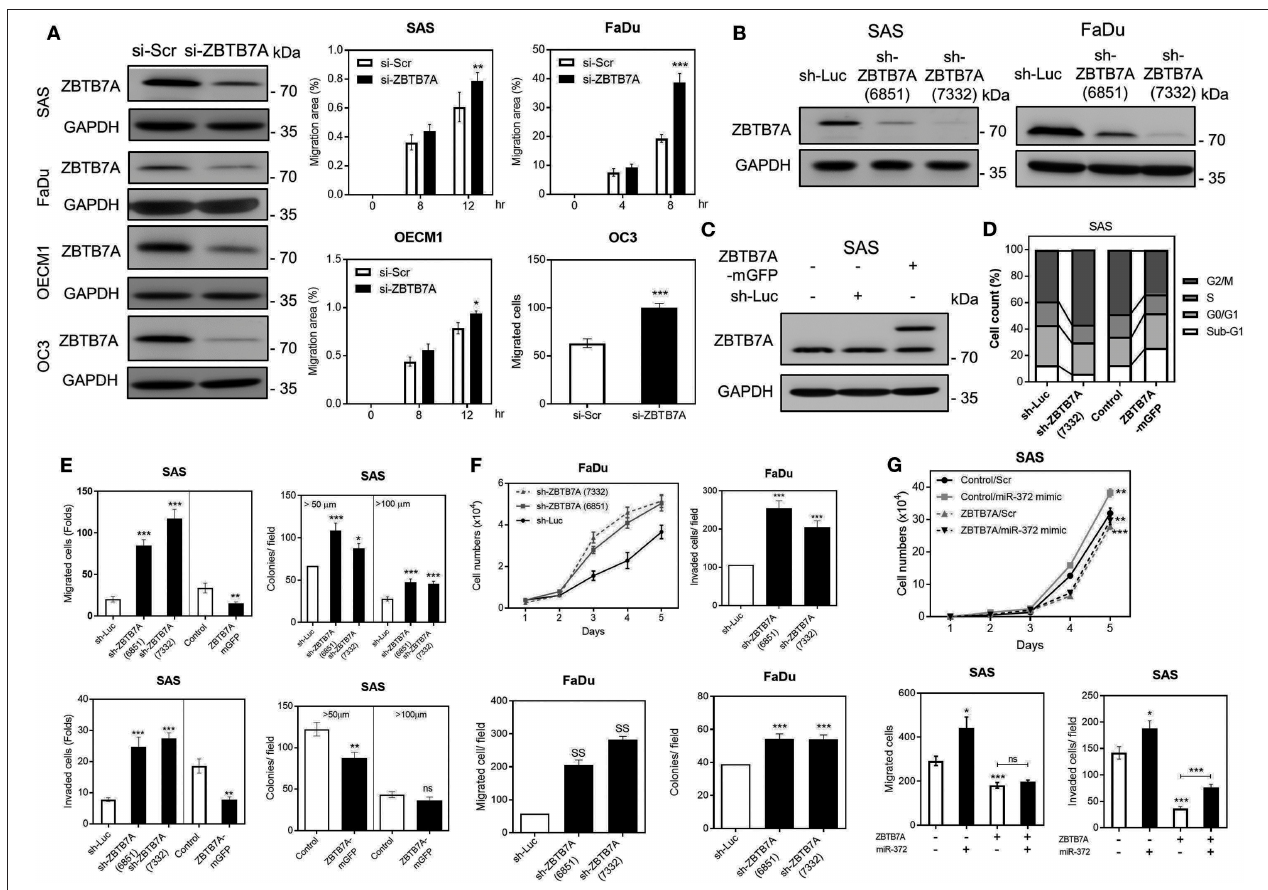
FIGURE 2 | ZBTB7A suppresses OSCC oncogenicity. (A) Transient transfection of si-ZBTB7A decreases ZBTB7A protein expression (Lt), and increases cell migration as revealed by wound healing migration assays using OSCC cells (Middle and Rt). Wound closure is used to assess migration ability. (B,C) Western blot analysis. (B) This reveals the decrease in ZBTB7A expression present in the ZBTB7A knockdown (sh-ZBTB7A) cell subclones. (C) The findings also reveal expression of the fusion protein in the ZBTB7A-mGFP cell subclones. (D) Summary of cell cycle profiles of the ZBTB7A knockdown and exogenous expression SAS cell subclones. The cell cycle phases in the synchronized cell subclones after CDDP treatment for 24h are shown. For details, please refer to Figure S4 . (E–G) Oncogenicity. (E) Increases and decreases in oncogenicity can be seen with the ZBTB7A knockdown and exogenous expression SAS cell subclones, respectively. (F) Increased proliferation, migration, invasion and anchorage-independent colony formation occur with the ZBTB7A knockdown cell subclone of FaDu. (G) miR-372 associated changes in proliferation (Upper), migration (Lower Lt), and invasion (Lower Rt) of SAS cells are rescued by exogenous ZBTB7A expression. ns , not significant, * p < 0.05; ** p < 0.01; *** p <